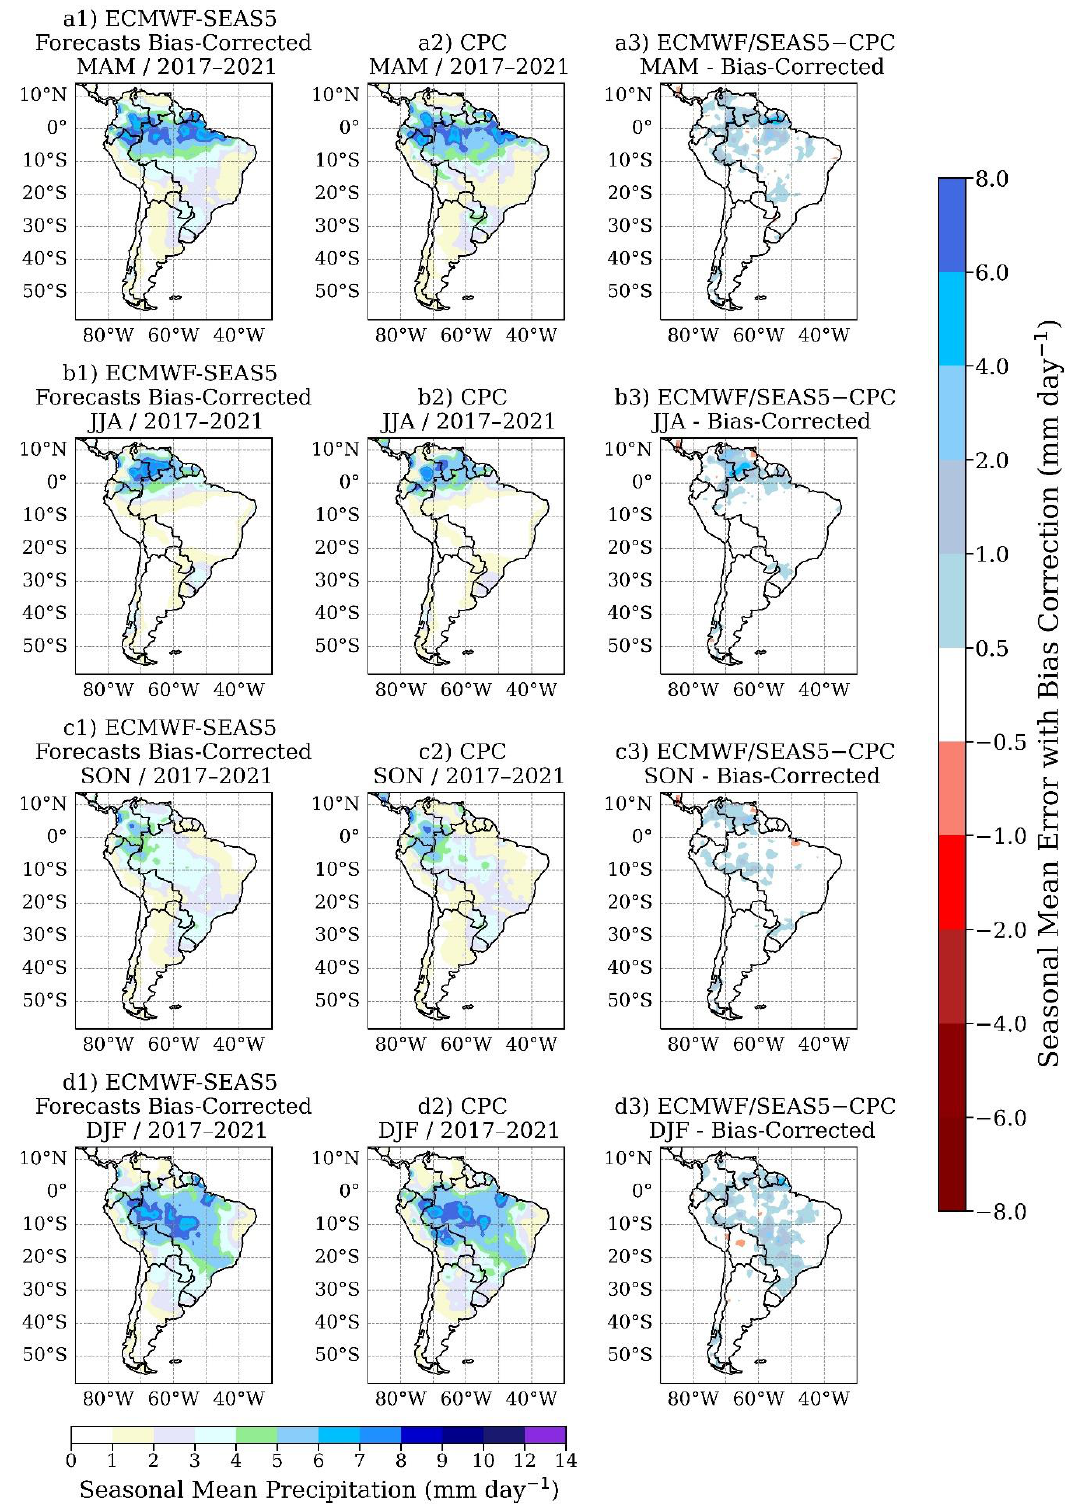
Figure 9. Left column : seasonal mean precipitation (mm day − 1 ) derived from the ECMWF-SEAS5 forecasts after bias correction, averaged for 2017–2021 and over the 51 ensemble members, for ( a ) MAM, ( b ) JJA, ( c ) SON, and ( d ) DJF. Center column : CPC seasonal mean precipitation (mm day − 1 ) averaged over 2017–2021. Right column : seasonal precipitation mean errors (mm day − 1 ) obtained by the difference between ECMWF-SEAS5 seasonal forecasts after bias correction and CPC, averaged over